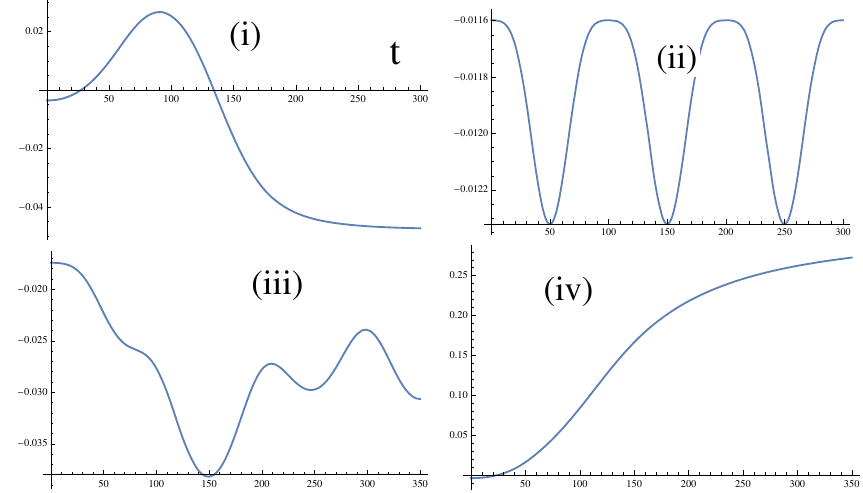
Figure 43 . The time evolutions of EE in the Dirac Fermion CFT for the choices (i), (ii), (iii), (iv) of subsystem A . We chose b = 50 and a = 50 (this corresponds to s = 0 : 945 : : : ( < 1)).